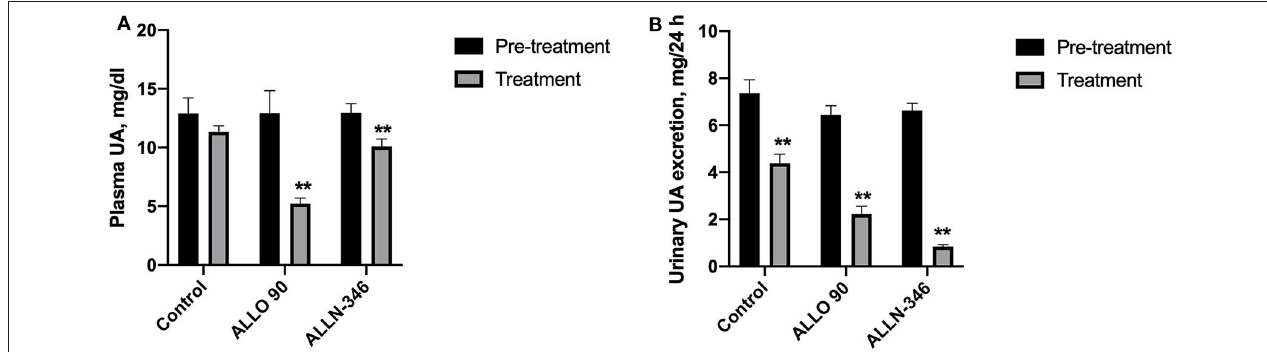
FIGURE 2 | Plasma UA level (A) and urinary UA excretion (B) in uricase/UrOx deficient mice following the 19-day study. Data are shown as mean ± SEM. Control group, no treatment ( n = 7); ALLO 90 group, allopurinol supplemented in drinking water (90 mg/L) ( n = 7); ALLN-346 ( n = 10), ALLN-346 mixed with food and provided for up to 6h. **Statistically significant differences considering p < 0.05 for comparison between pretreatment and treatment periods.